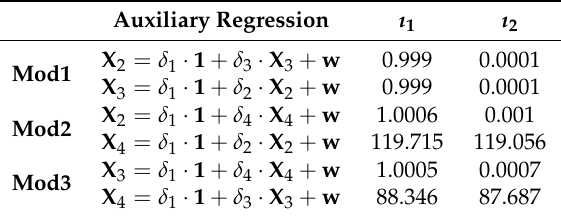
Table 8. Calculation of ı j for situations Mod1 , Mod2 and Mod3 shown in Example